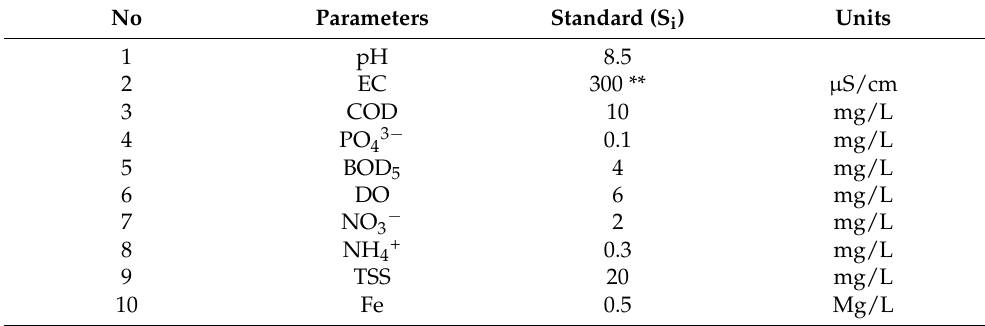
Table 3. Water parameters for WAWQI calculation [30]. (QCVN 08-MT:2015/BTNMT, Column A1-Ministry of Natural Resources and Environment-Vietnam Environment Directorate). No Parameters Standard (S i )